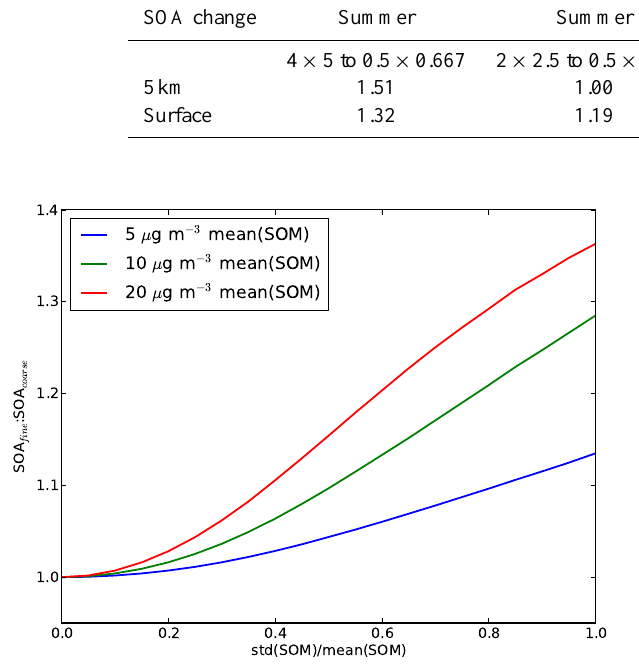
Fig. 12. The ratio of the average enhancement in monoterpene SOA for a fine resolution above a course resolution as a function of the standard deviation of SOM of the fine grid within the course grid (normalized by the mean SOM